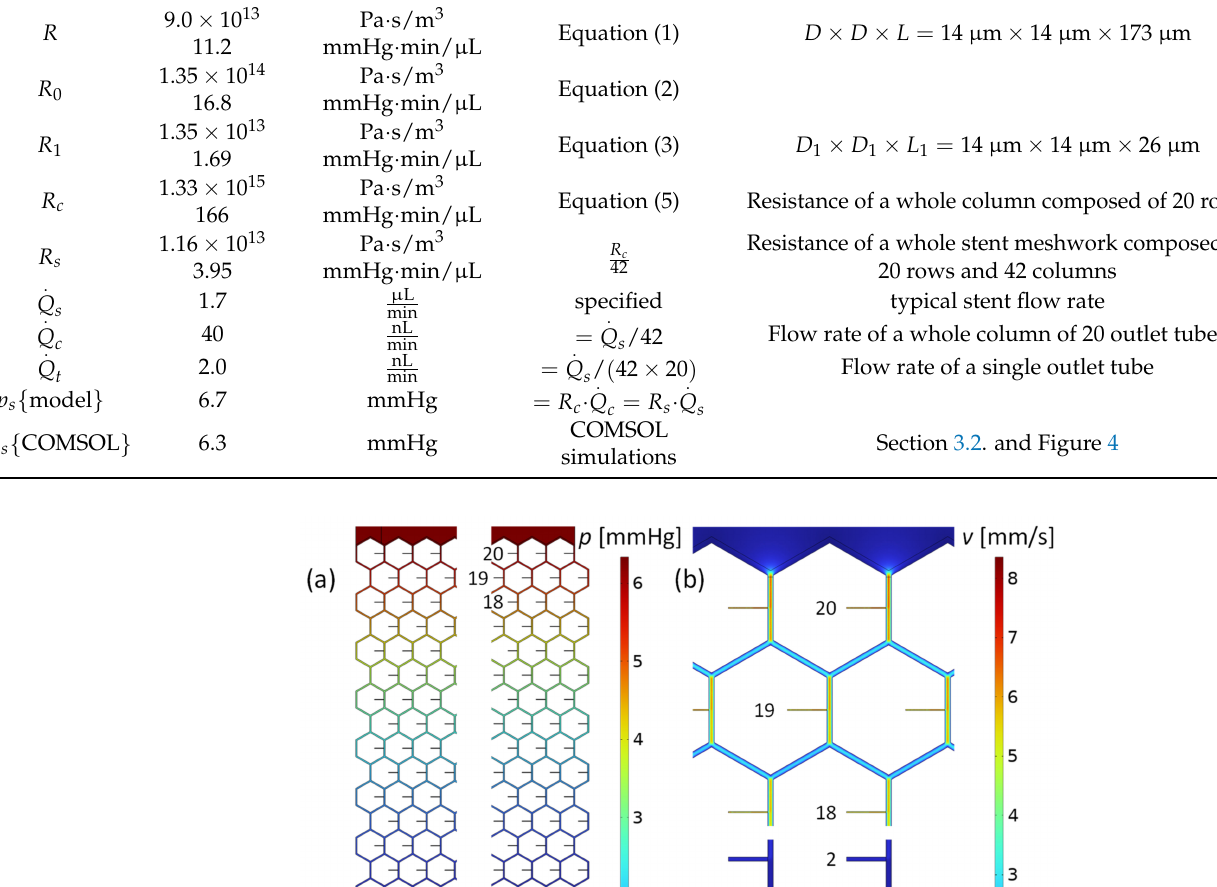
. Q s is an example value after